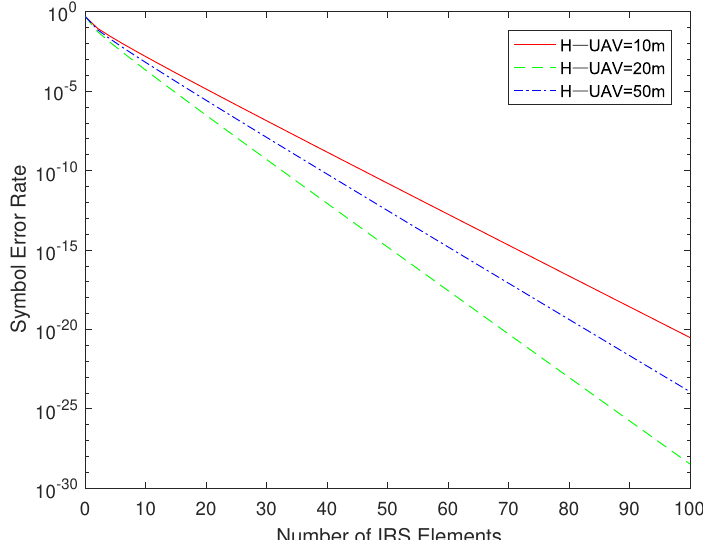
Figure 2. Symbol error rate versus the number of IRS